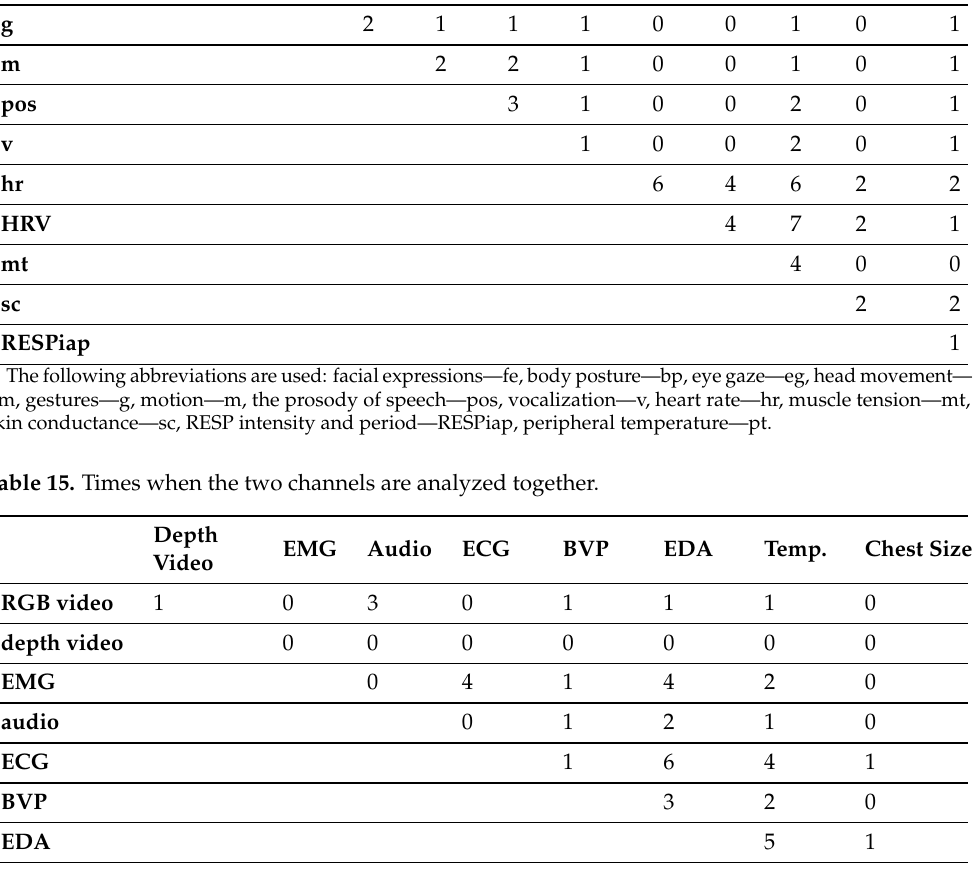
Table 14. Times when the two modalities are analyzed together.